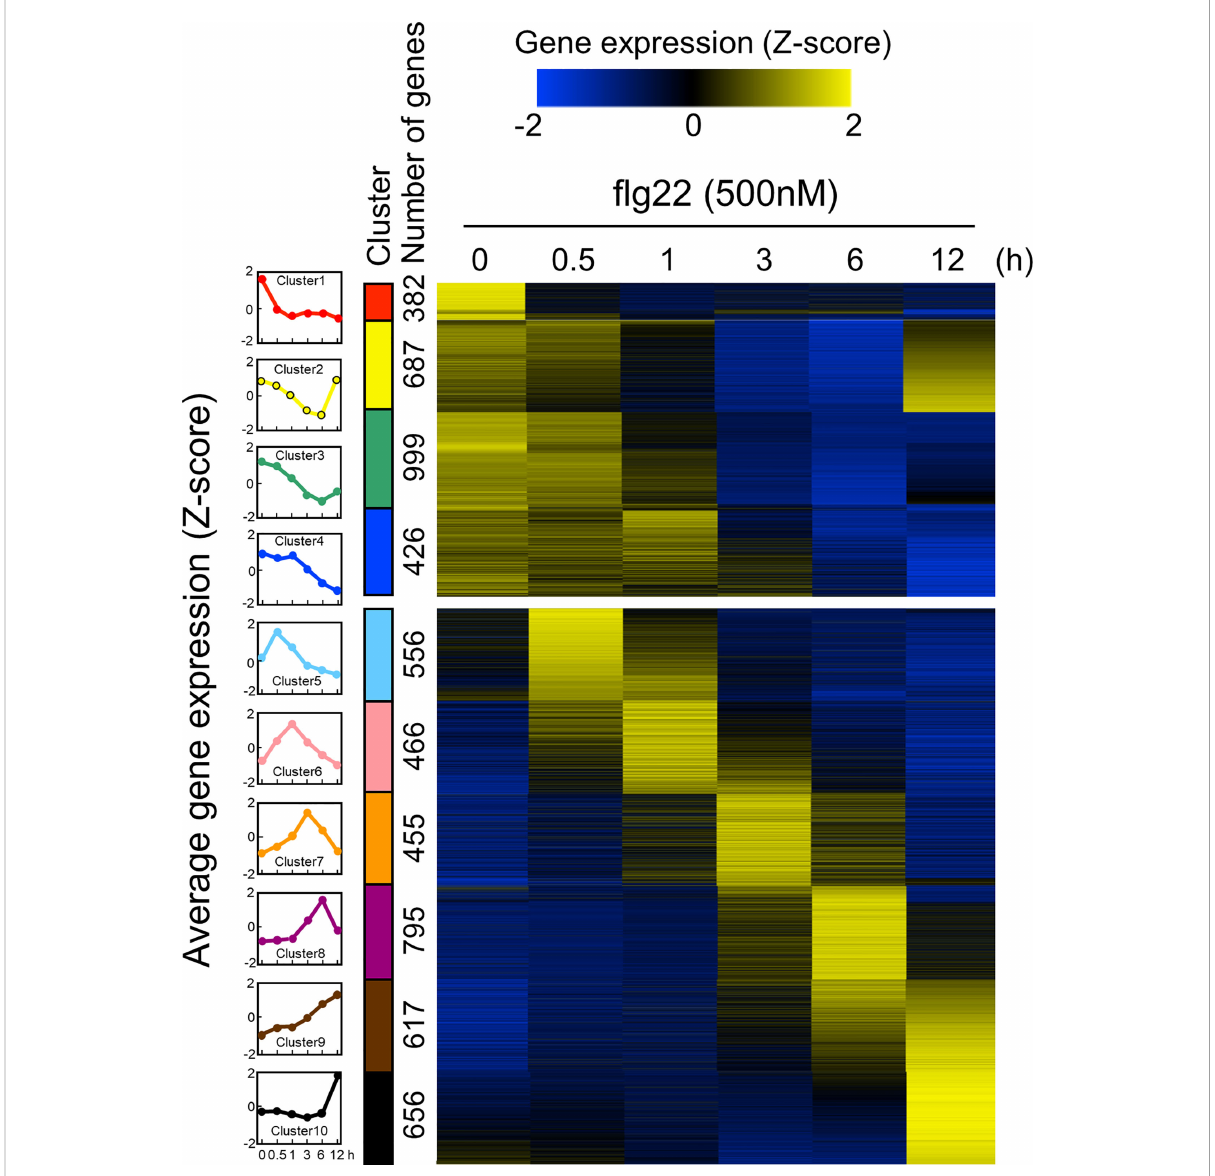
FIGURE 2 Expression patterns of Brachypodium distachyon genes in leaf disks treated with fl g22. A total of 6,039 differentially expressed genes (DEGs) were identi fi ed by RNA-seq analysis of leaf disks treated with fl g22 for the indicated time periods. Expression levels of genes at different time points were converted to z-scores and displayed as a heatmap. As shown in the scale bar, the higher expression values compared with the other time points are represented in yellow color. The fl g22-responsive genes were classi fi ed into 10 clusters using the k-means clustering method based on their expression patterns. The average expression pattern of each cluster, top 4 and bottom 6 are down- and upregulated genes, respectively, and shown on the left column with different colors. The number of genes in each cluster is shown along with the colored